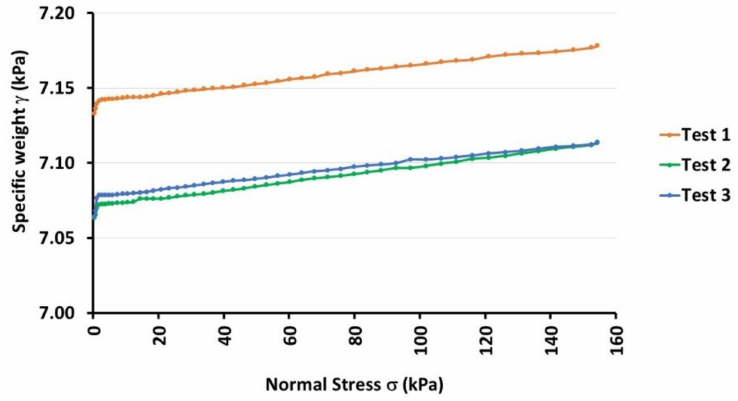
Figure 14. Change in apparent specific weight for the wood pellets with changing normal stress.